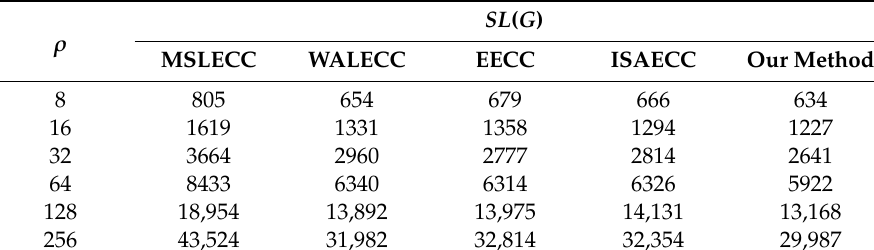
Table 5. Results of FFT applications for varying number of tasks.